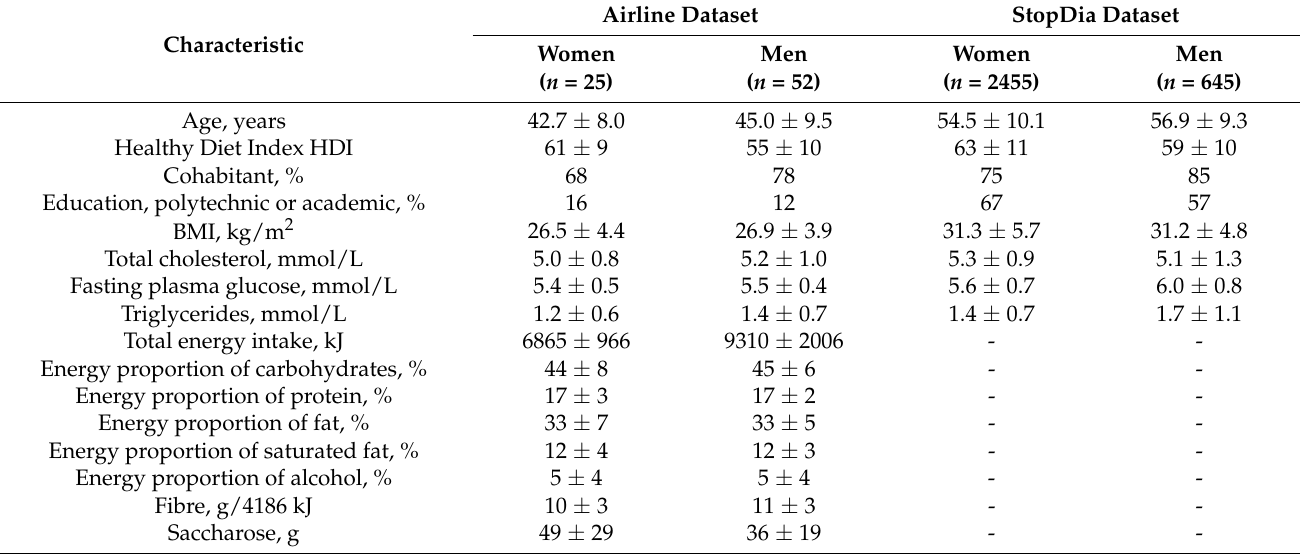
Table 1. Characteristics (mean ± standard deviation or %) of validation